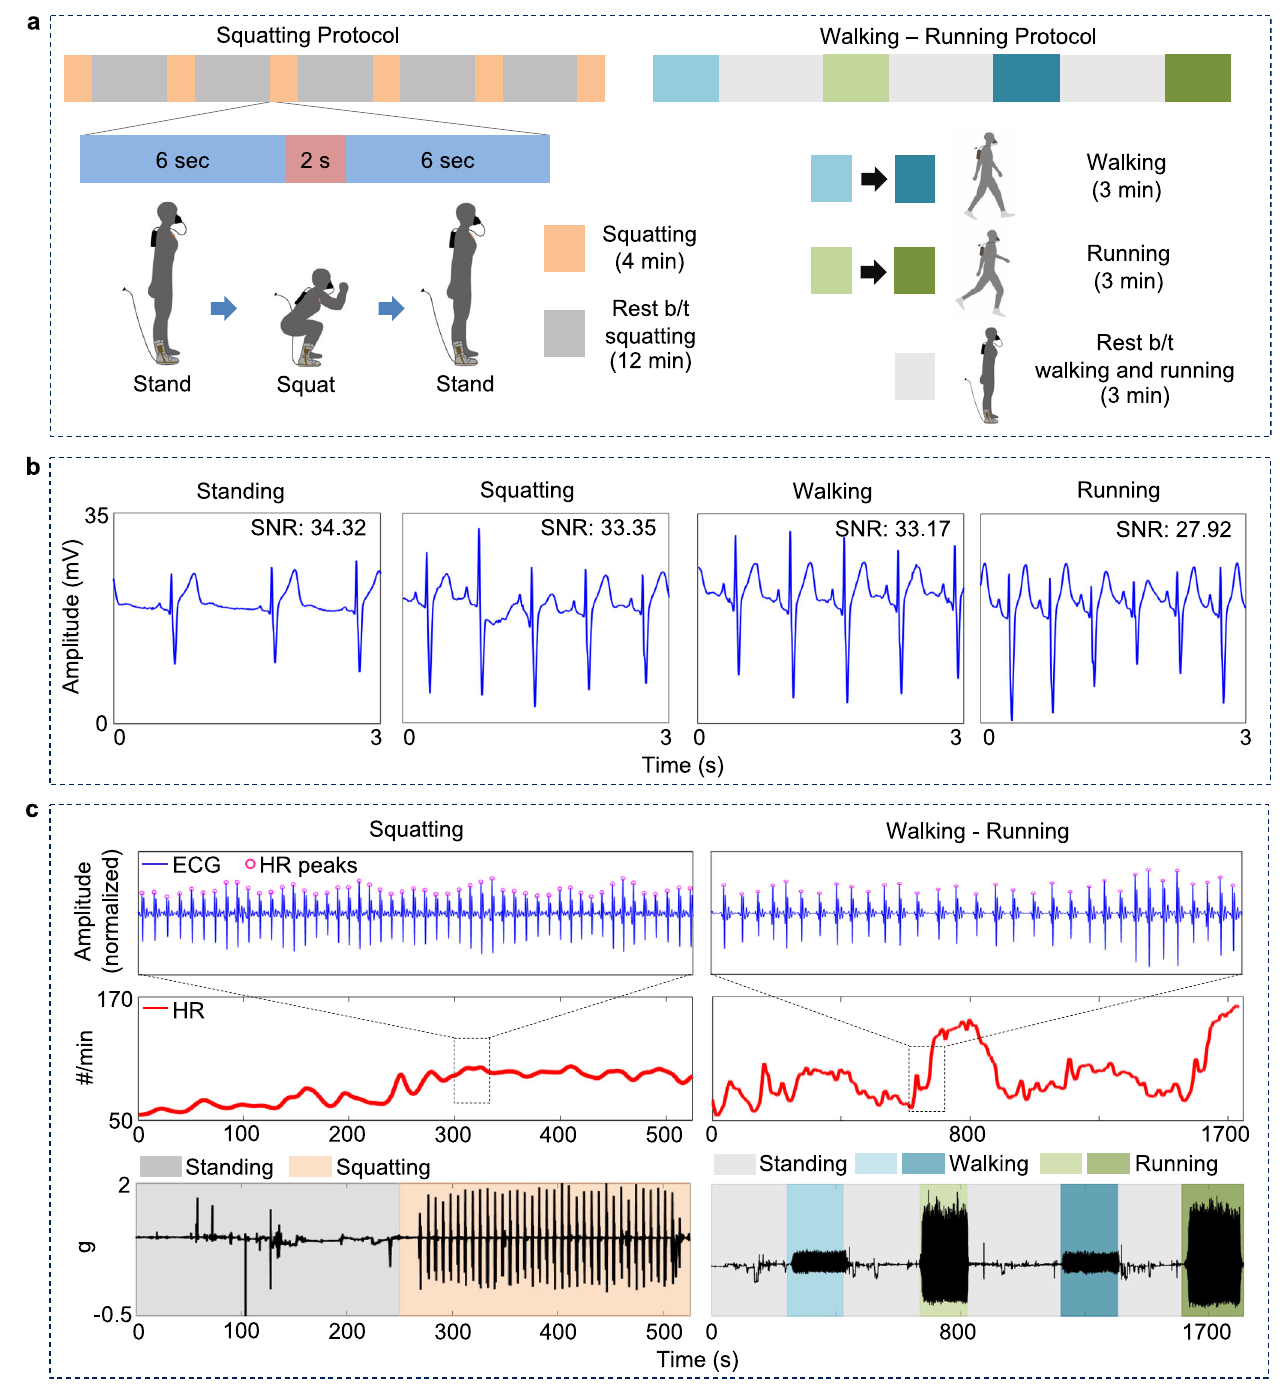
Fig. 4 Experimental setup and performance validation of an SFB integrated with a wearable system. a Timestamp and illustration of squatting and walking-running experimental protocols. The color saturation on the right side indicates elevation changes. b Representative ECG data showing 3 s of peak shapes and SNR during standing, squatting, walking, and running with an AFO. No signi fi cant degradation and motion artifacts in the signal qualities are observed during standing and running. c Filtered and normalized ECG data during 30 s of squatting and walking-running session (top), moving average of HR for squatting and walking-running conditions (middle), and vertical axis acceleration during activities, including standing, squatting, walking, and running (bottom). RR, and HRV-RMSSD data from the single session are shown in Supplementary Fig. 11, including standing, squatting, walking, The designed model shows 91% test accuracy and 97% training and running with a gradient of 0 – 4. accuracy (training and loss curve in Supplementary Fig. 12). In